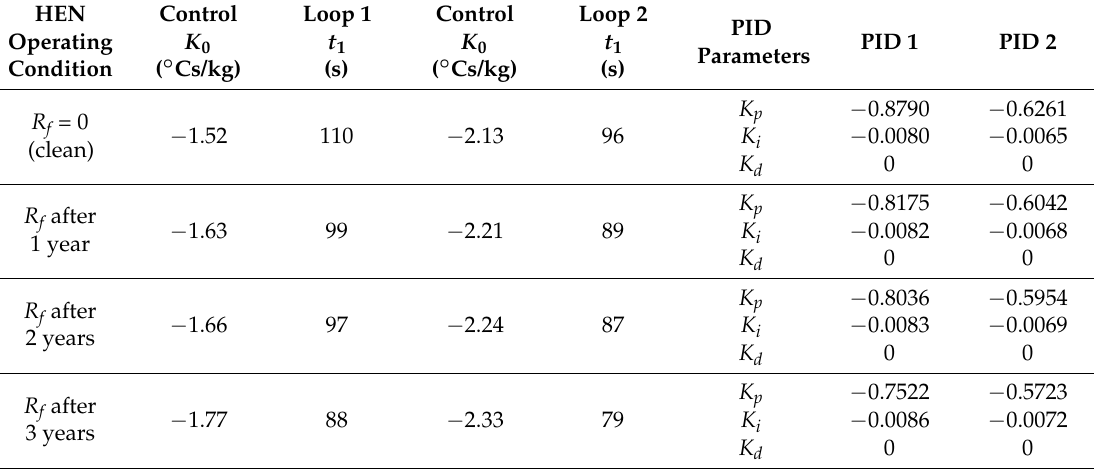
Figure 14. Open-loop step responses under fouling conditions of the control variable CV 1 ( a ) and CV 2 ( b ) on a 10% increase in the inlet mass flow M At and M Ct . Table 3. Values of PID controller parameters obtained using the Skogestad method [20] in case no. 1.